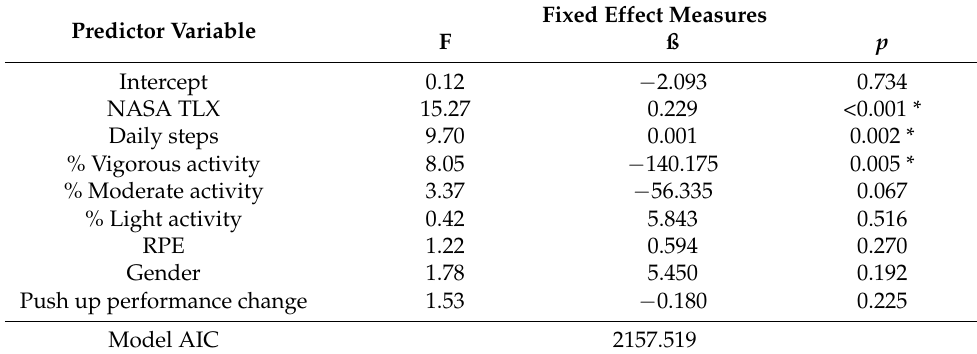
Table 2. Model of best fit for predicting MTDS total